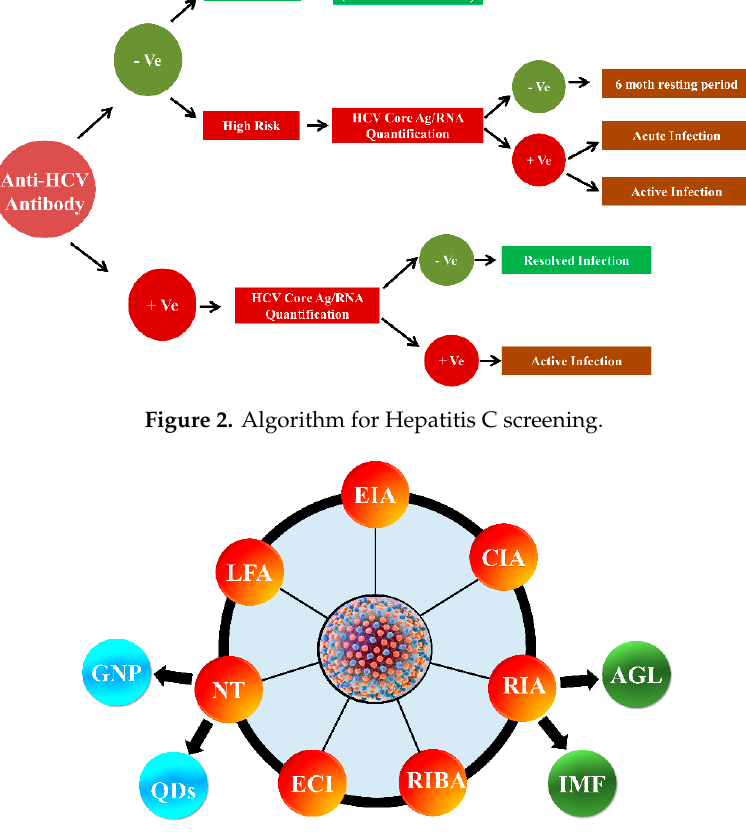
Figure 3. Various methods used for the qualitative and quantitative detection of hepatitis C